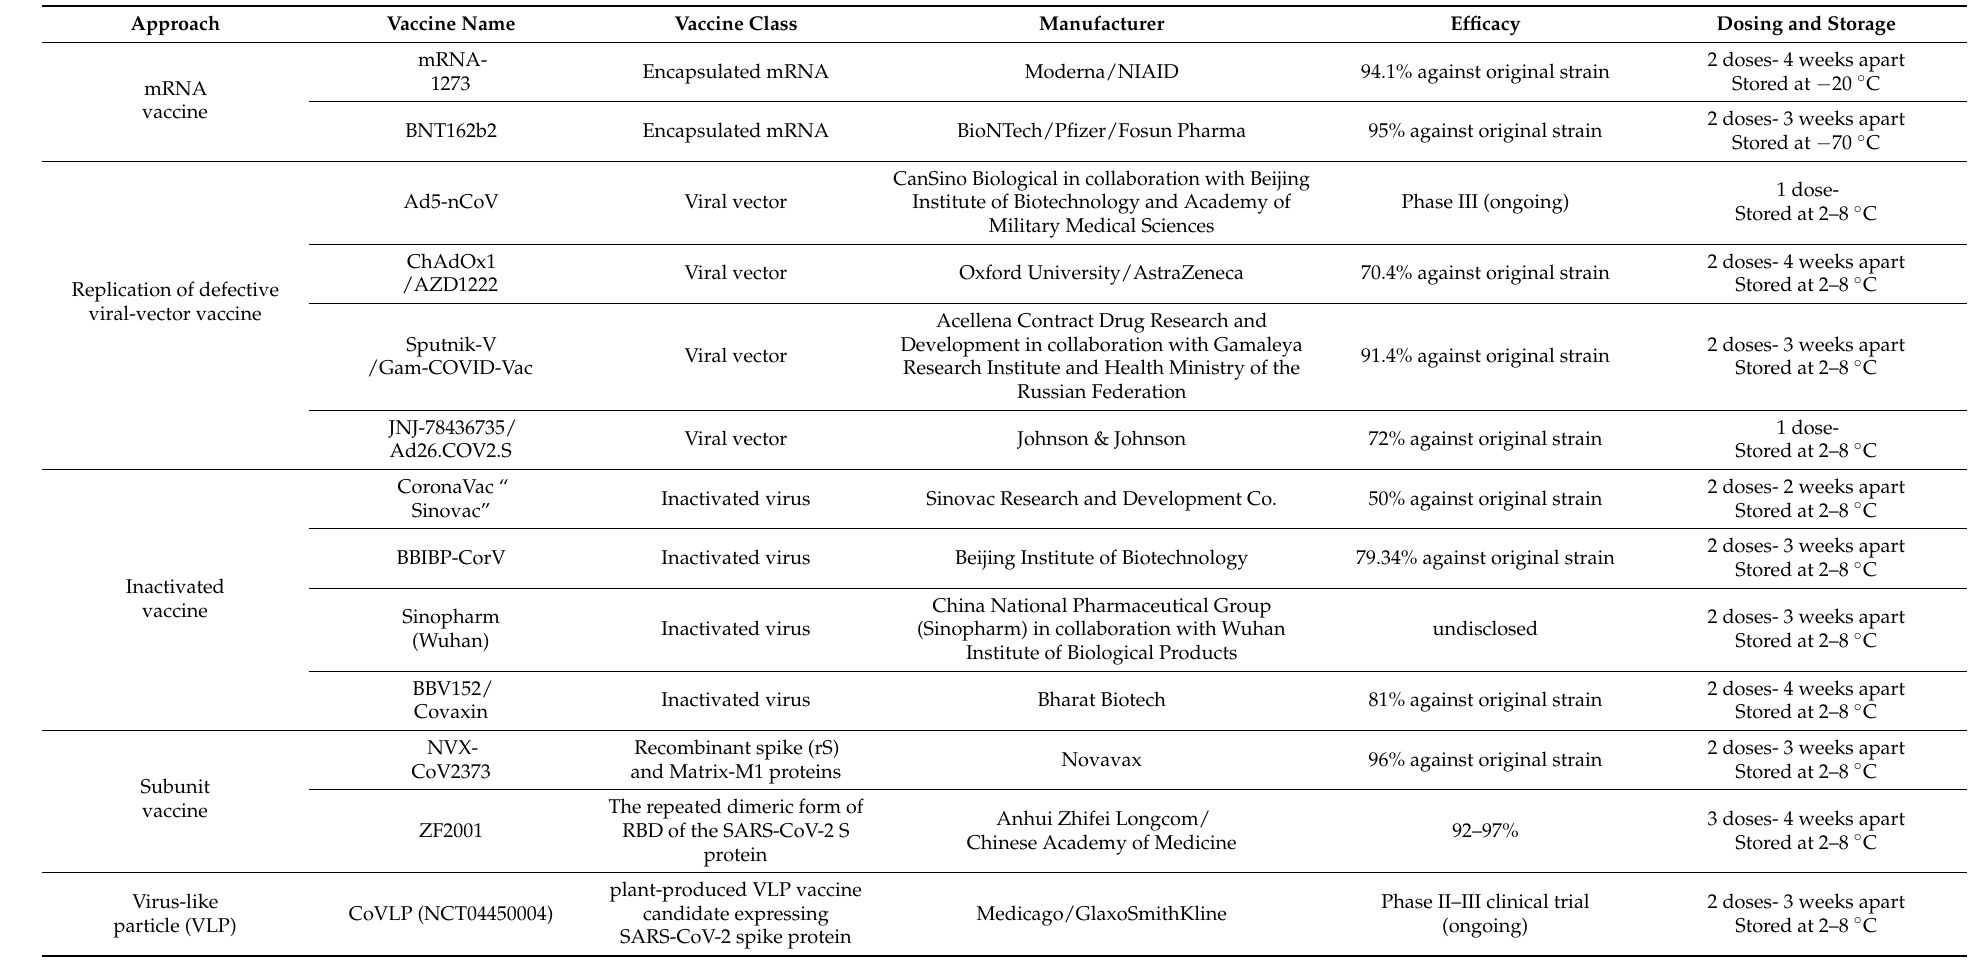
Table 2. Vaccines licensed for use against COVID-19